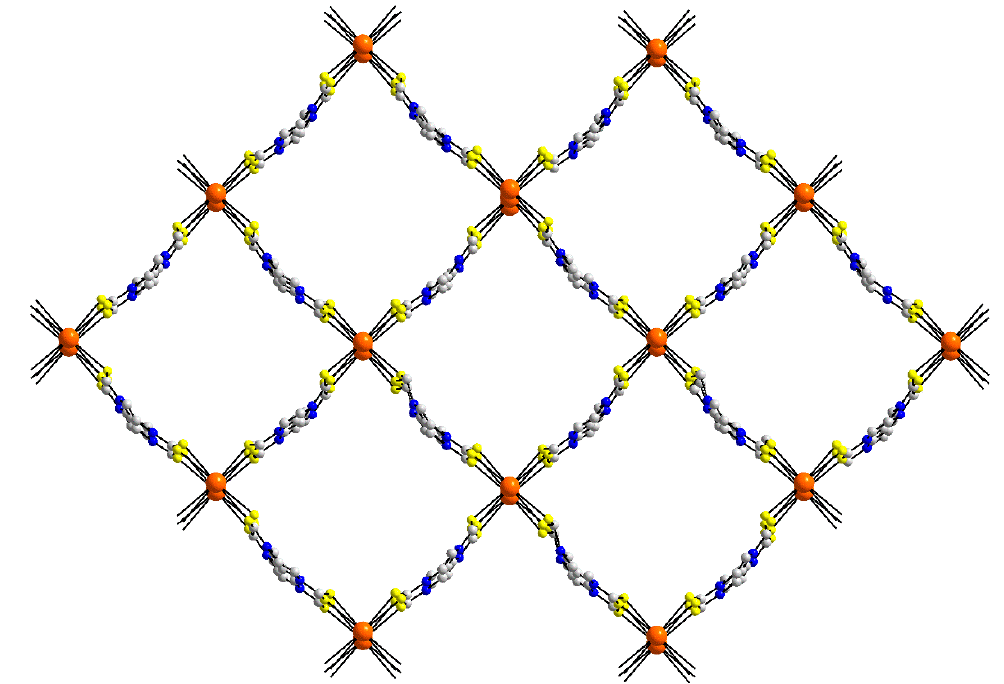
Figure 20. A view in projection down the c -axis of the three-dimensional framework defined by {[Nd(L 2 ) 2 ] − } n anions in the crystal of 102 .